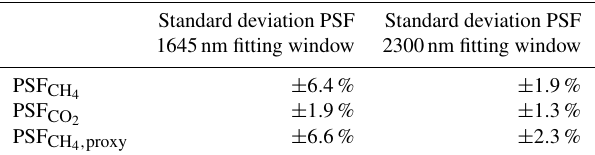
Table 1. Comparison of the standard deviation of PSF CH and PSF CH in the two fitting windows around 1645 and 4 , proxy 2300nm for the AVIRIS-NG FWHM ( ≈ 6nm). The standard de- viation was calculated over a homogeneous and flat area with no visible plume and possible source inside. The statistical uncertain- ties in PSF CH and PSF CO are therefore 4 2